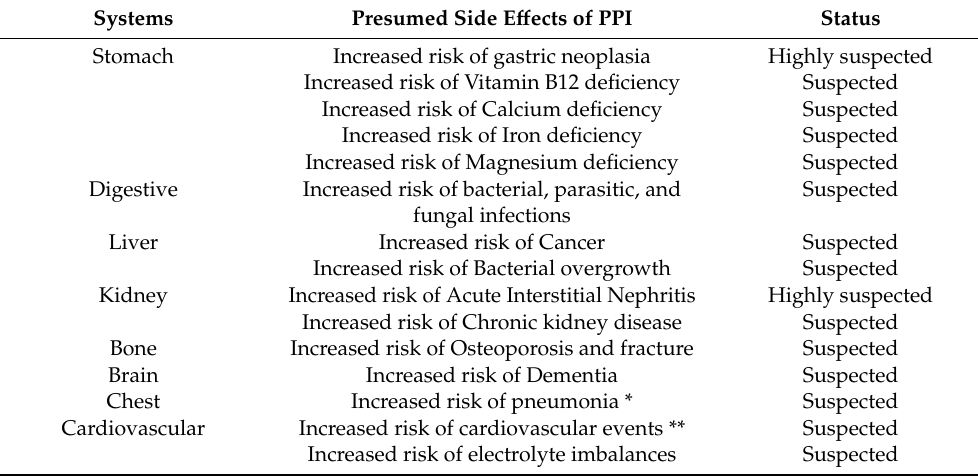
Table 3. Long-term Side E ff ects of Proton pump